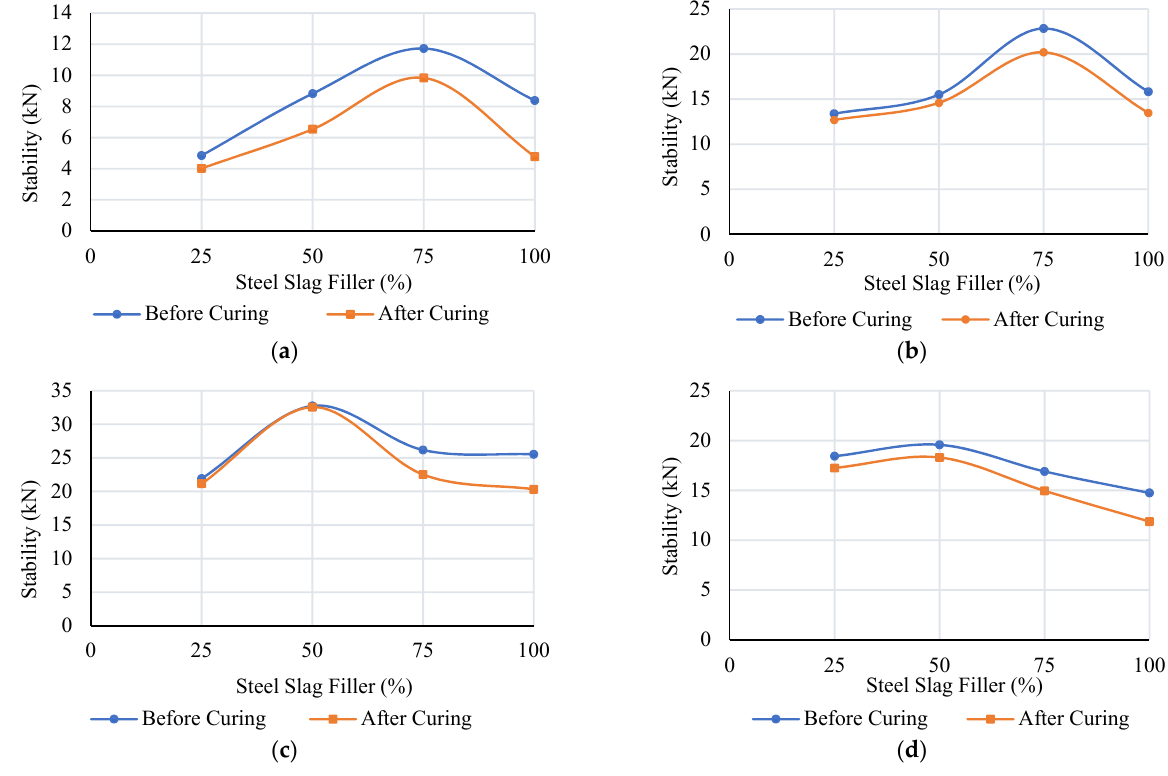
Figure 6. Marshall stability values for the asphalt mixes tested under water and prepared with ( a ) 25% RAP; ( b ) 50% RAP; ( c ) 75% RAP; ( d ) 100% RAP.